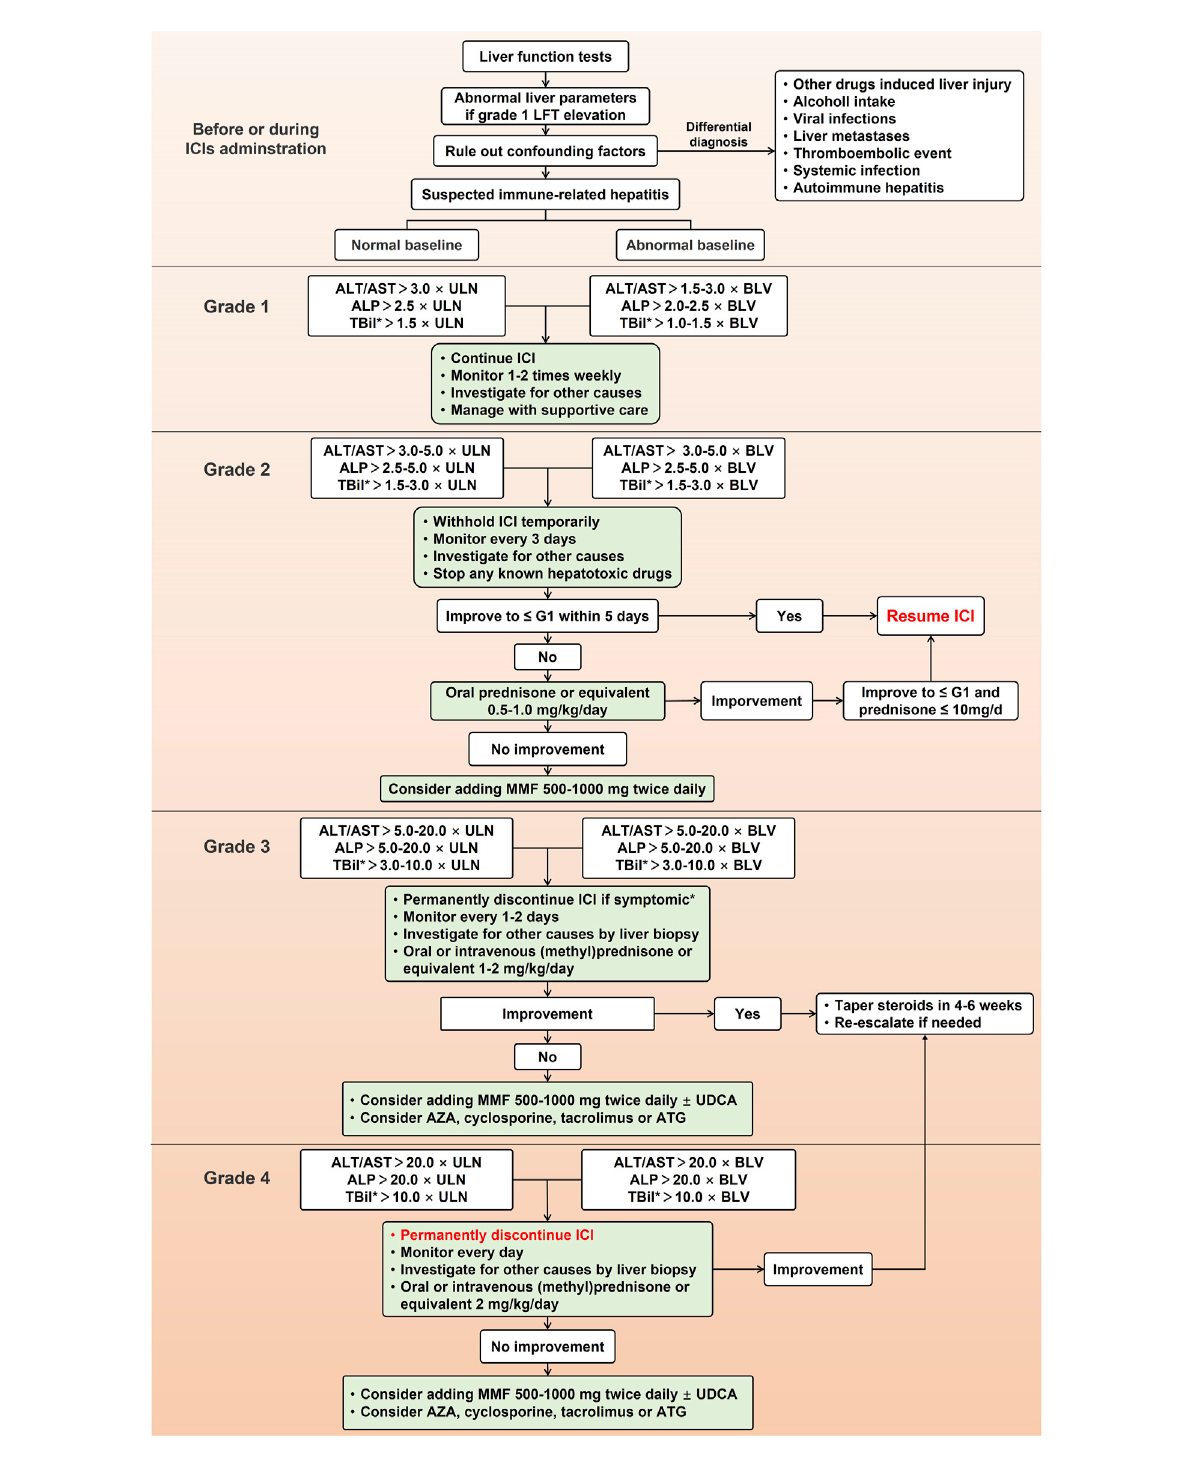
FIGURE 2 Management for immune-mediated hepatitis caused by immune checkpoint inhibitors. LFT, liver function test; ICI, immune checkpoint inhibitor; ALT, alanineaminotransferase; AST, aspartate aminotransferase; ALP, alkaline phosphatase; TBil, total bilirubin; ULN, upper limit of normal; BLV, baseline value; MMF, mycophenolate mofetil; UDCA, ursodeoxycholic acid; ATG, antithymocyte globulin; AZA,